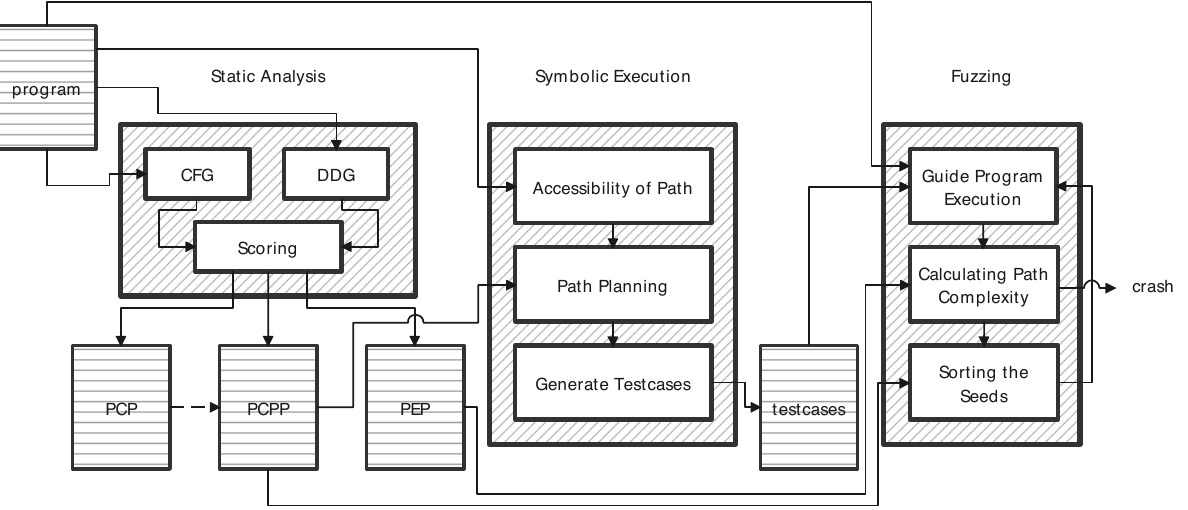
Figure 2. Overview of